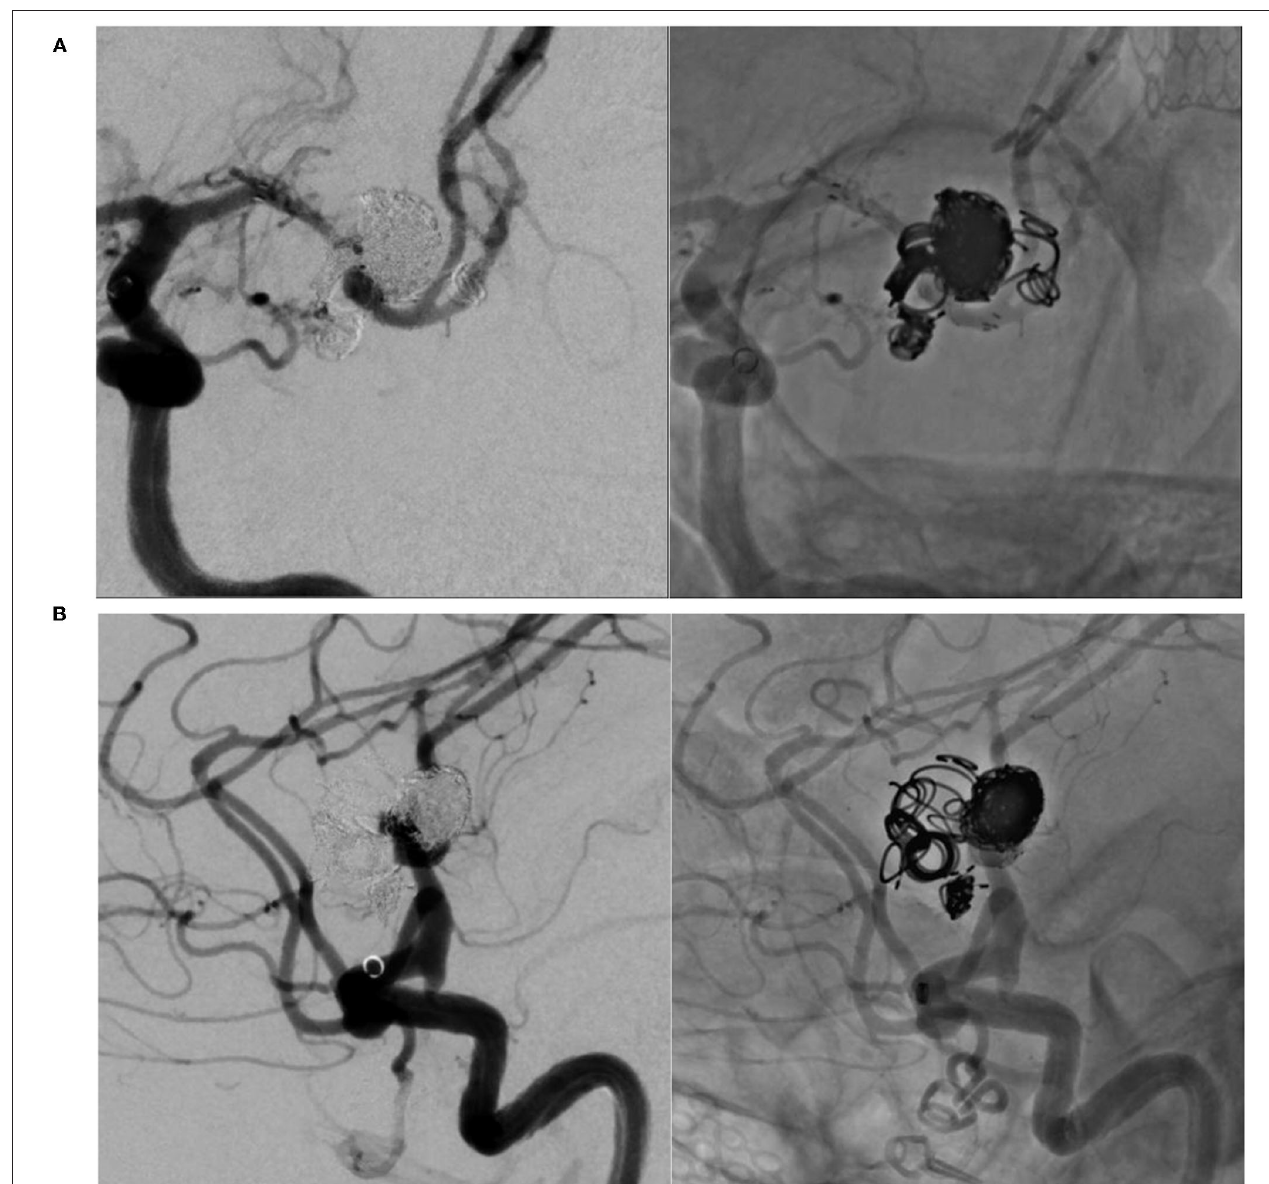
FIGURE 4 | (A) Flow diverter deployment following coil insertion in the antero-posterior view. Coil embolization is performed with ten detachable coils (Barricade complex framing; Blockade Medical, Irvine, California, USA, Axium Prime 3D; Medtronic). (B) In a lateral view. The aneurysm underwent a subtotal filling, and the artery, where flow diverter (FD) was deployed, was slightly